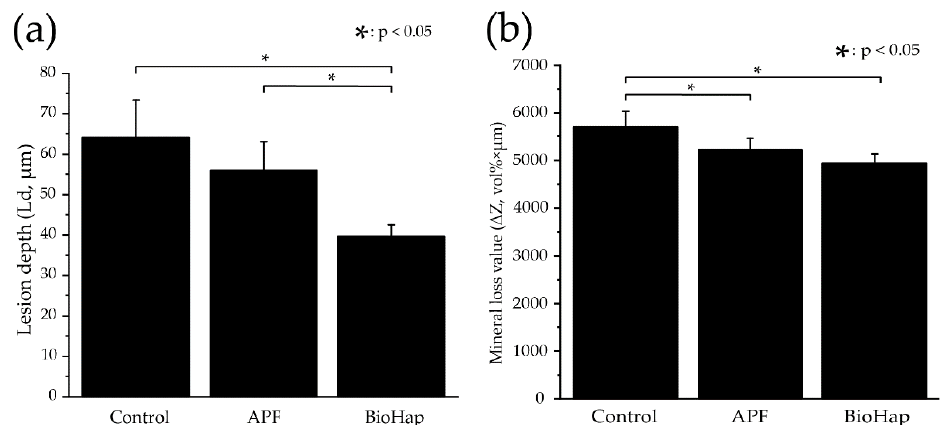
Figure 6. Comparison of measured lesion depth (Ld) and mineral loss value ( Δ Z) by contact micro- radiography after acid challenge. ( a ) Shows the different test groups for Ld ( n = 5). The horizontal axis indicates various preventive treatments, and the vertical axis indicates the Ld ( μ m) of the ex- perimental surface. ( b ) Shows the different test groups for Δ Z ( n = 5). The horizontal axis indicates various preventive treatments, and the vertical axis indicates the Δ Z ( μ m) of the experimental sur- face.